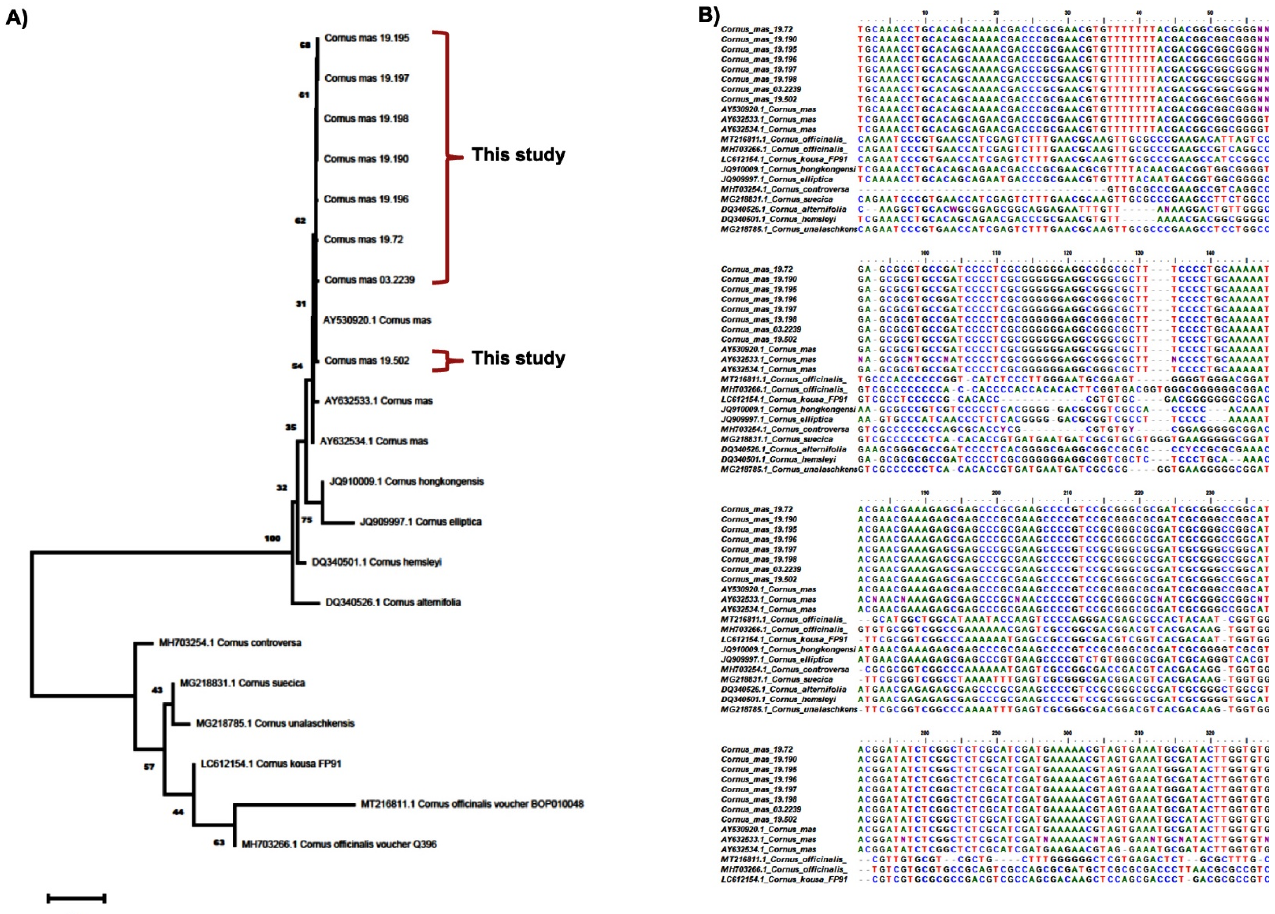
Figure 1. ( Α ) Phylogenetic tree on the basis of ITS2 regions regarding the Greek native Cornus mas genotypes in contrast with other C. mas and Cornus spp. genotypes of different origin retrieved from NCBI. (B) Overview of the genotypes analyzed in this study with multiple sequence alignment of their ITS2 barcode region. Results from neighbor-joining (NJ) bootstrap analyses with 1000 replicates were used to assess the strength of the nodes. The node numbers indicated the bootstrap value of NJ. The distinct genotypes of this study are highlighted with blue